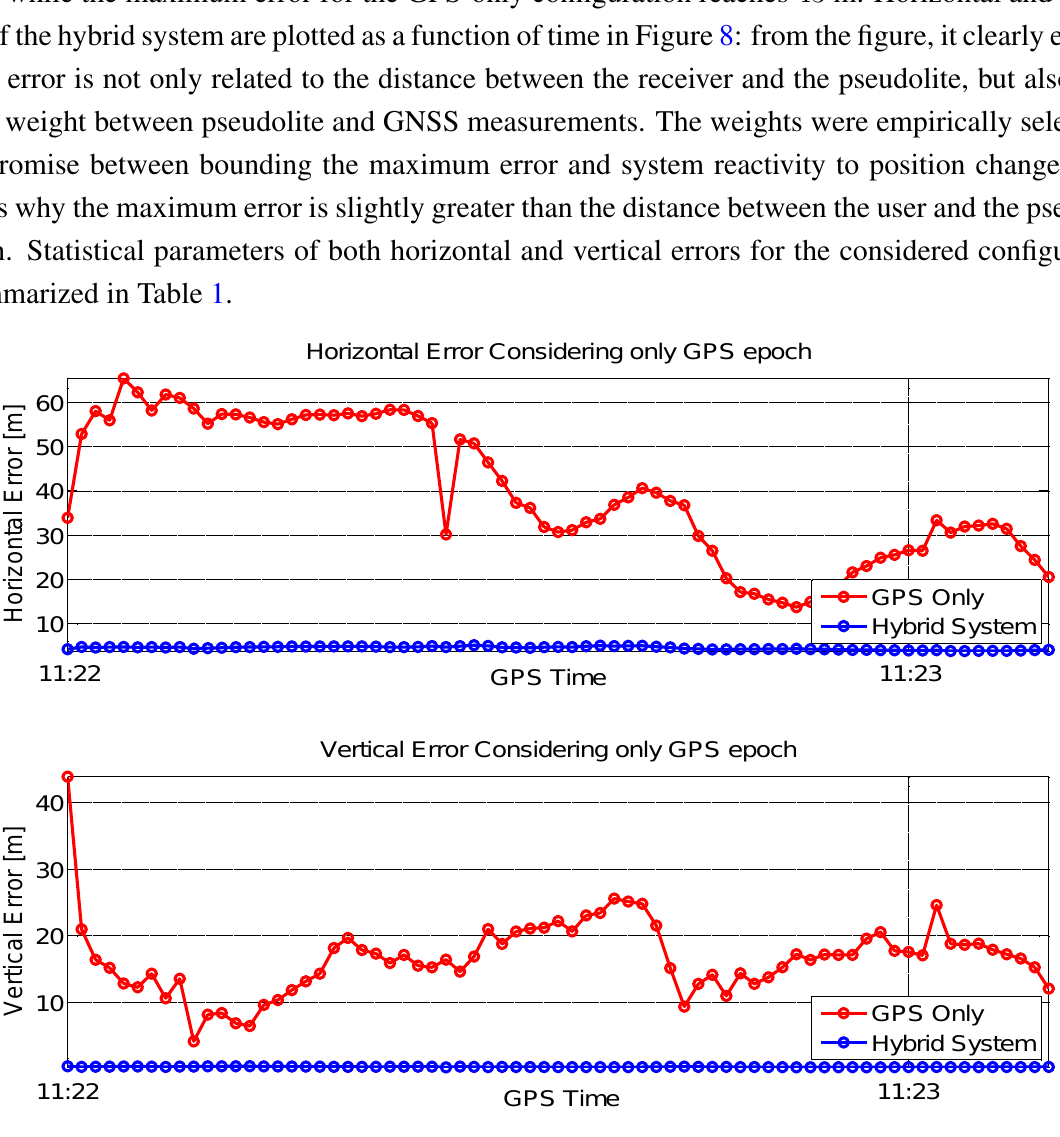
Figure 7. Horizontal and vertical errors for the partially-obstructed